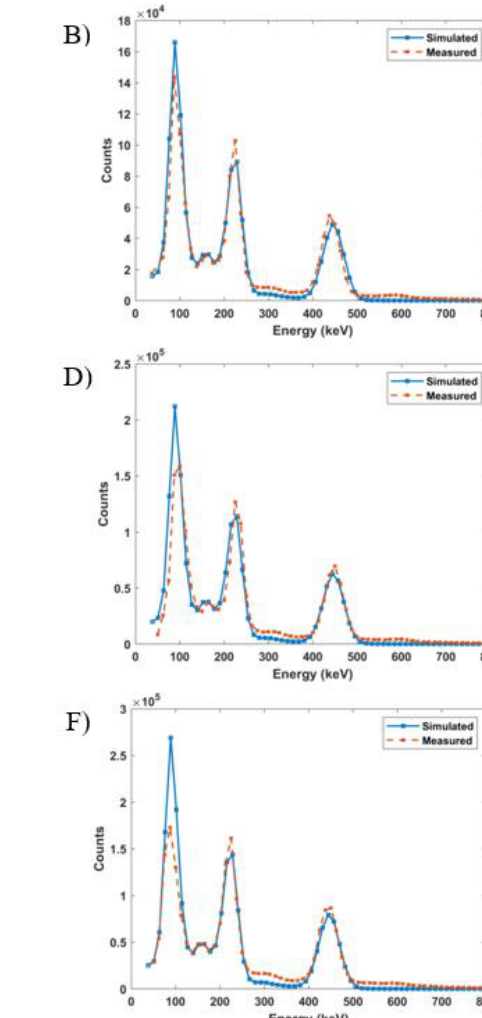
Figure 6. The mean percent difference between measured spectra and simulated spectra using the ion chamber reading measurement as input for the Monte Carlo model.